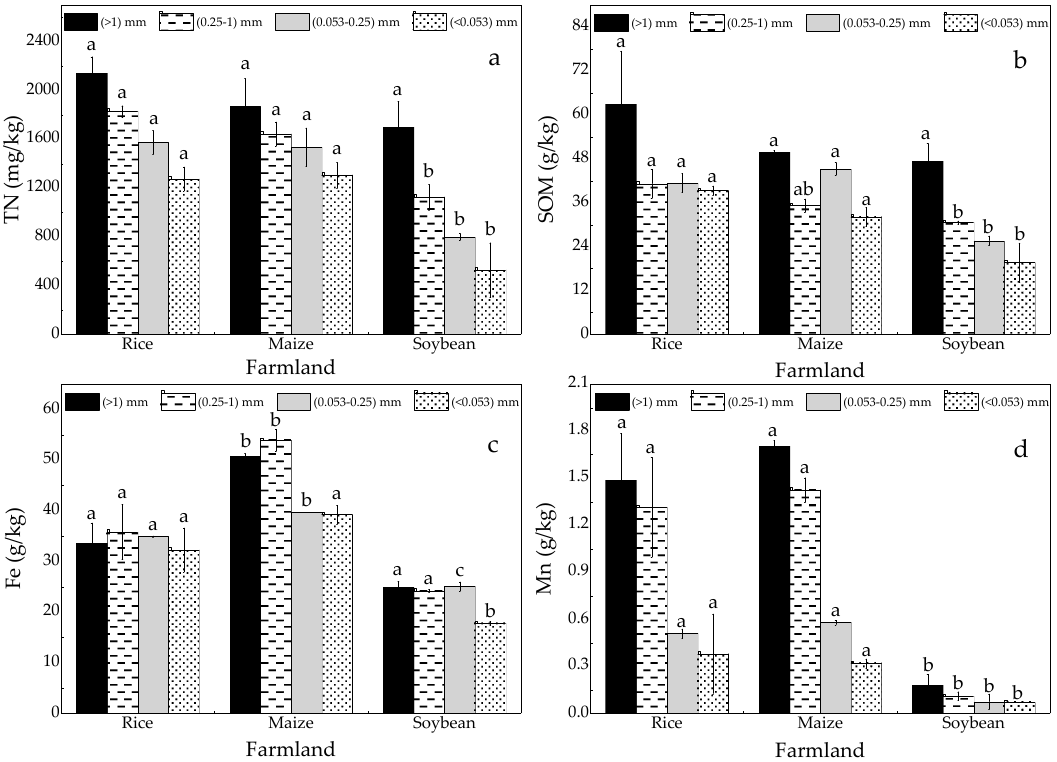
Figure 2. The content of ( a ) TN (Total nitrogen), ( b ) SOM (soil organic matter), ( c ) Fe and ( d ) Mn in soil aggregate fractions. Note: the letters a, b indicate the significant difference in the amount of chemical indicators in the same grain-size soil aggregate under different land uses.